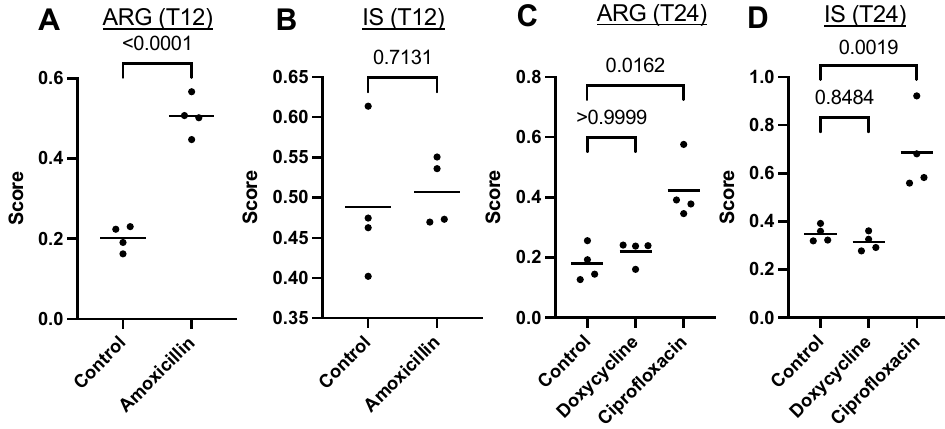
Figure 1. Quantification of ARGs ( A , C ) and ISs ( B , D ) for different antibiotic treatments. T12 and T24 indicate that the treatments were either administered for 12 h or 24 h. p values are shown for all comparisons versus